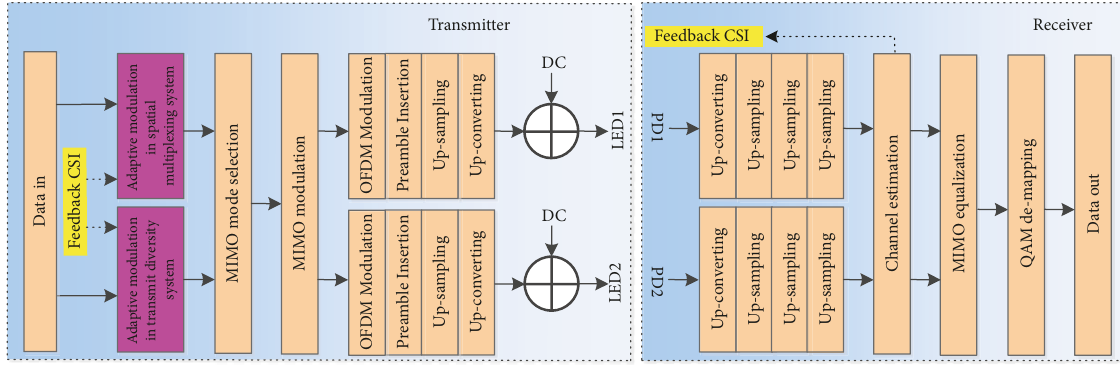
Figure 1: Block diagram of the switching MIMO VLC system with adaptive OFDM